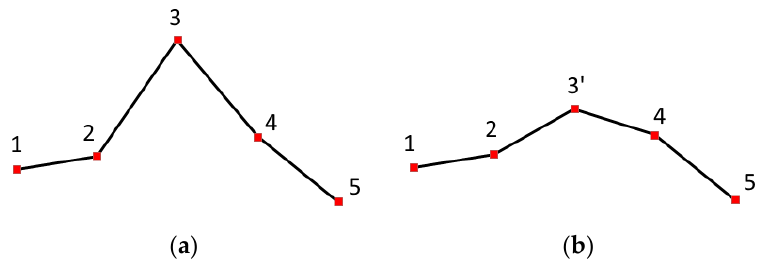
Figure 18. Part of the curve where the local smoothing filter is applied: ( a ) before the smoothing and ( b ) after the smoothing. ( b ) after the smoothing. Water 2020 , 12 , x FOR PEER REVIEW